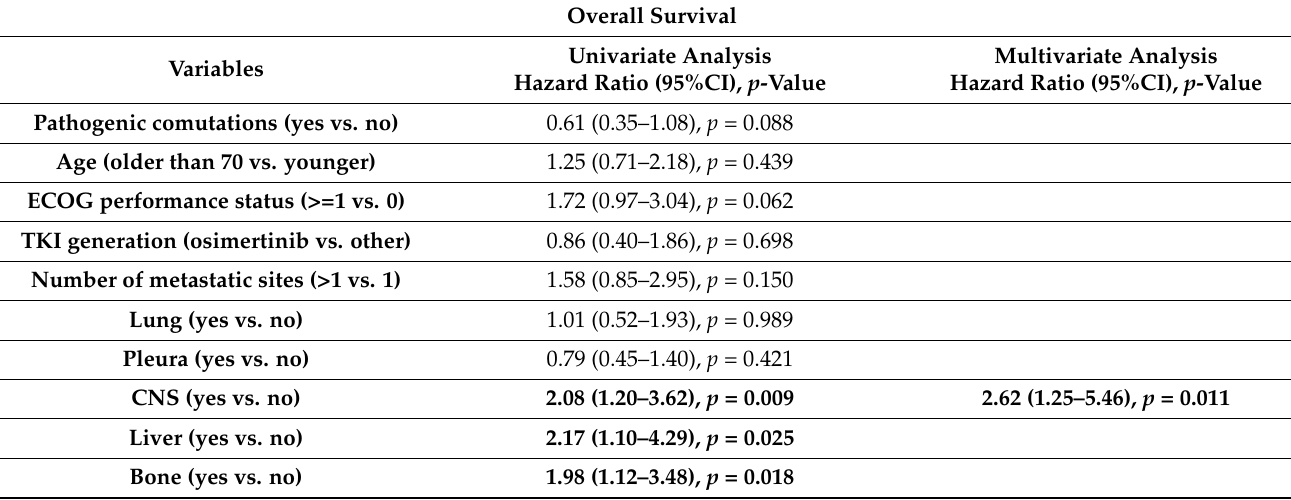
Table 3. Univariate and multivariate analysis for overall survival. Bold indicates statistically significant findings ( p <